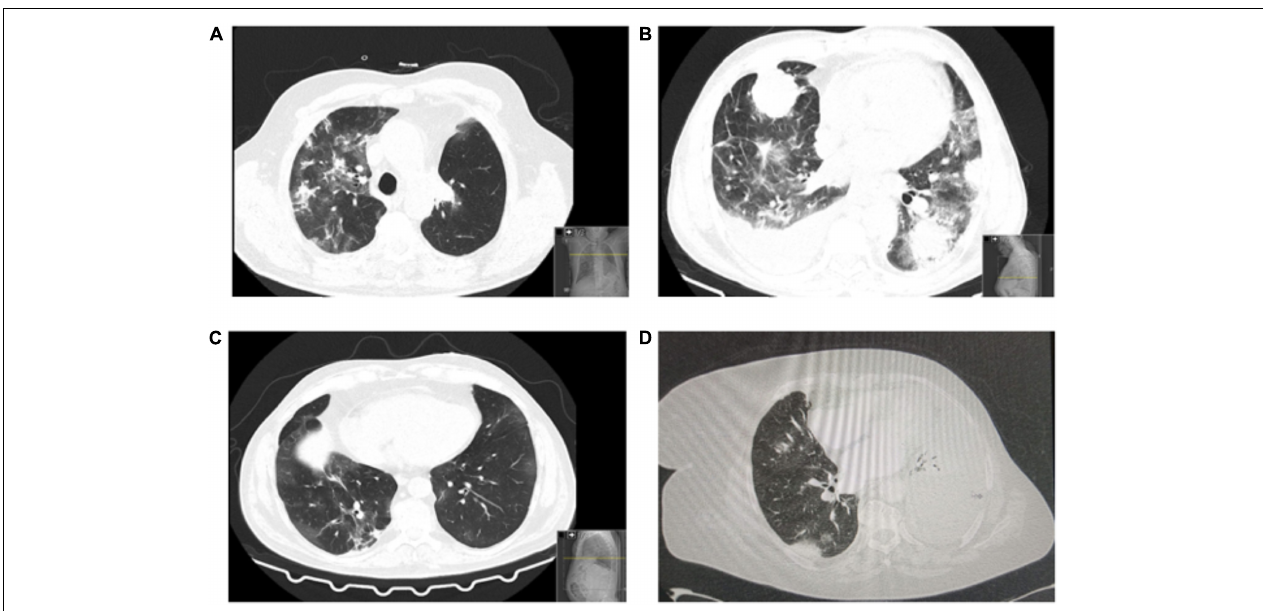
FIGURE 1 | Patients’ chest CT scans. (A) Bilateral predominantly peripheral ground-glass opacities. Asymmetrical consolidations in the right lobes suggestive of concomitant bacterial infection. Left upper lobe lobectomy signs (consistent with recent surgery). (B) Patient with multiple findings related to coronavirus disease 2019 (COVID-19) and the underlying lung cancer: bilateral ground-glass opacities, pulmonary mass and pleural implant, right pleural effusion. (C) Chest CT: bilateral ground-glass opacities, both central and peripheral, some with nodular shape. Some “band” consolidative opacities in the right upper lobe, middle lobe, and lower inferior lobe opacities suggestive of residual processes. (D) Left large-volume pleural effusion with left lung atelectasis. Diffuse ground-glass opacities. Small right pleural effusion. No signs of pulmonary